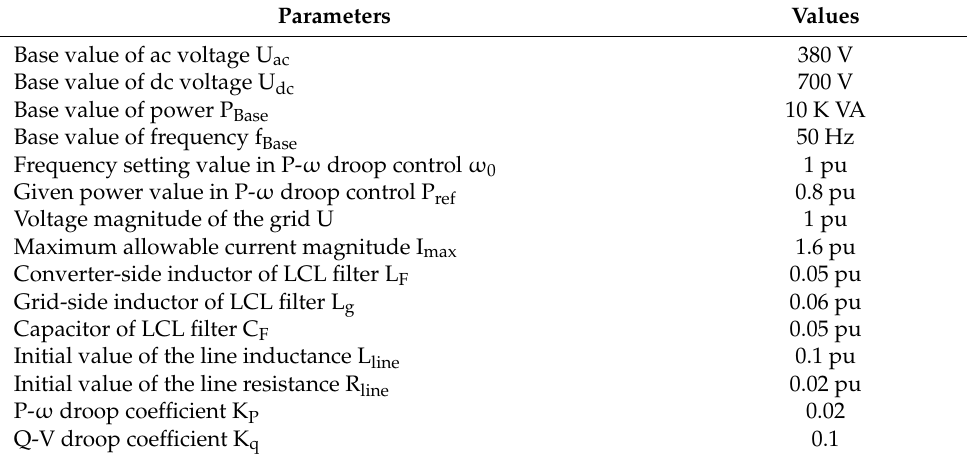
Table 1. Parameters of simulation model.